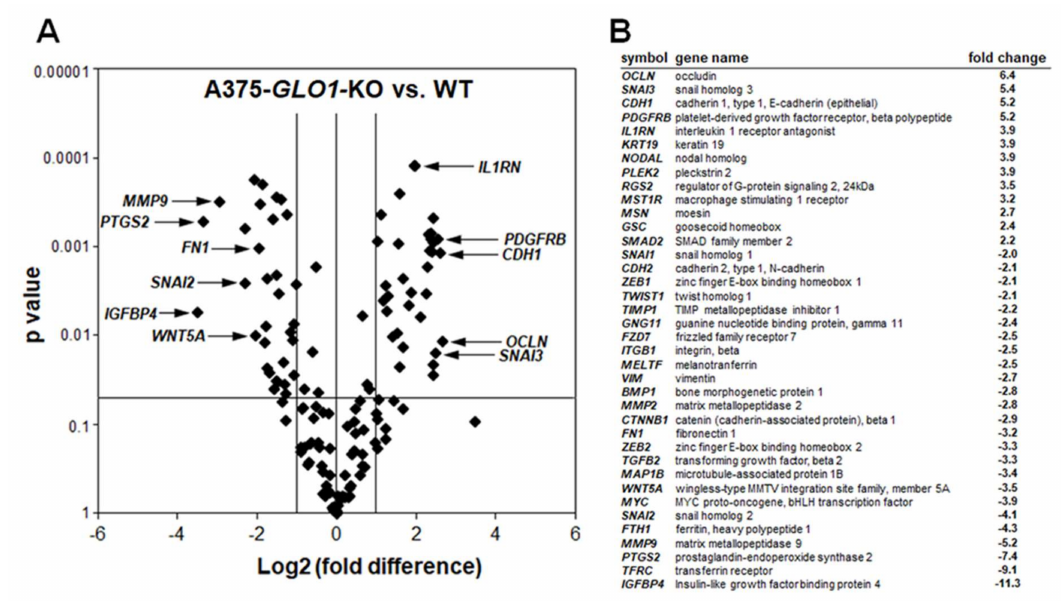
Figure 3. Array analysis indicates downregulation of epithelial mesenchymal transition (EMT)-related gene expression in human A375 malignant melanoma cells with genomic GLO1 deletion. ( A ) Volcano plot depicting di ff erential gene expression (WT versus B40_KO), as detected by the RT 2 Profiler TM PCR expression array technology; (cut-o ff criteria: expression di ff erential > 2; p value ≤ 0.05; n = 3). ( B ) Numerical expression changes [B40_KO versus WT] revealing modulation of EMT-related genes as a function of GLO1